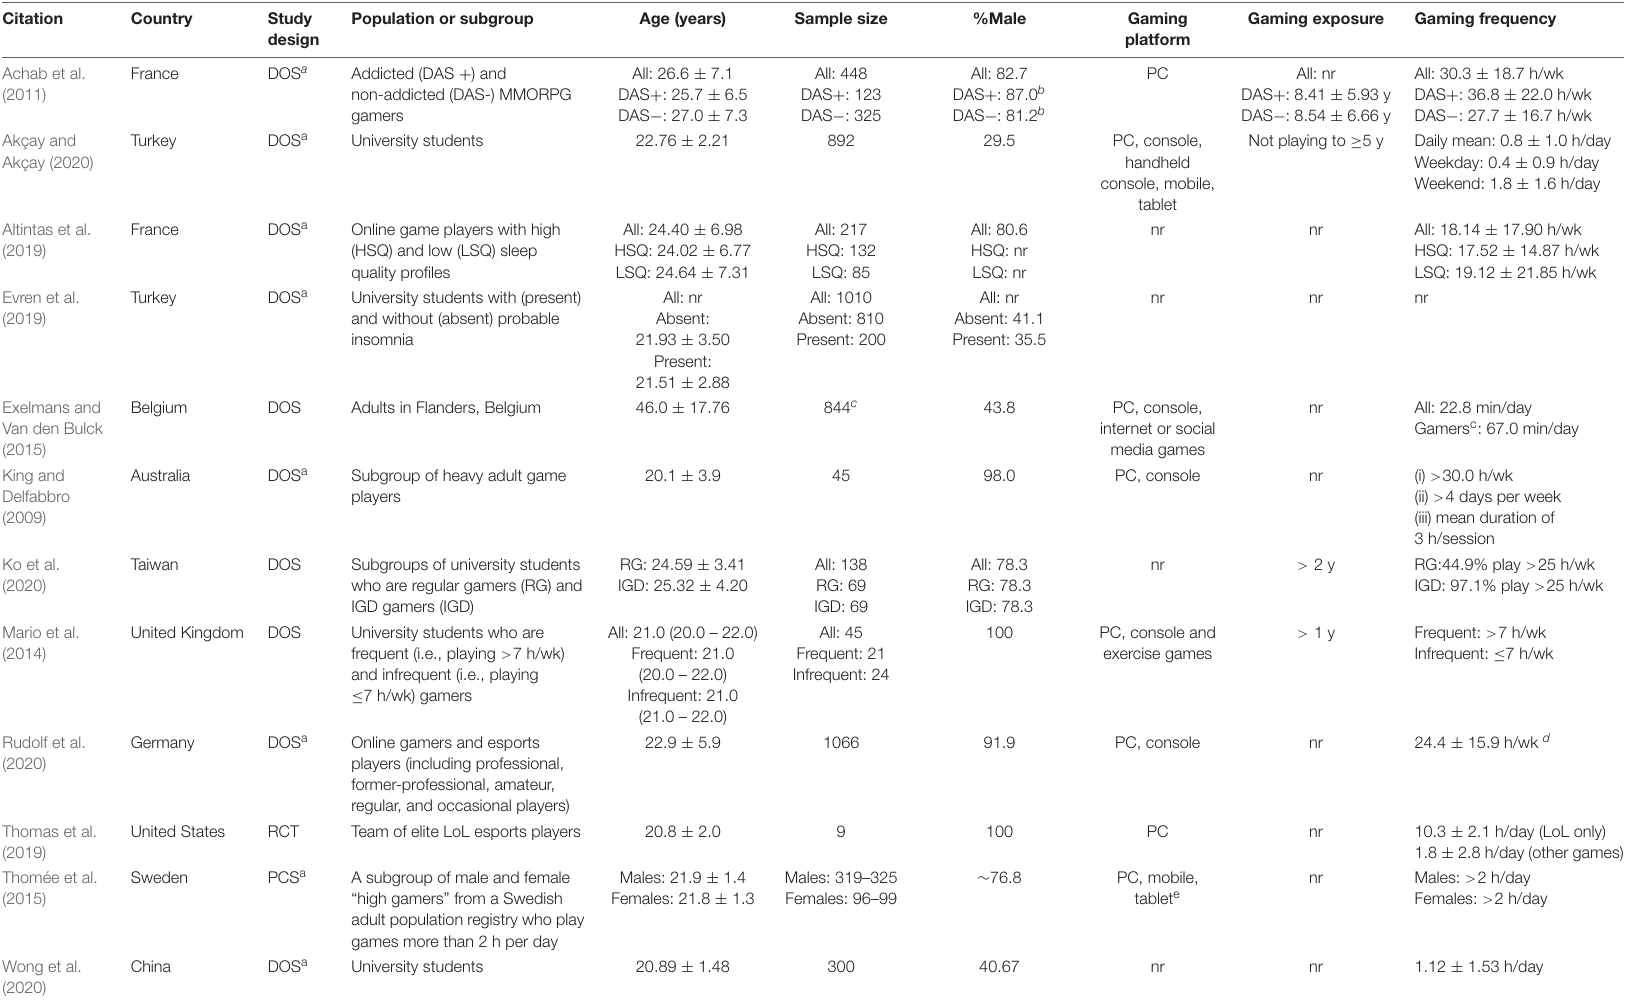
TABLE 2 | Demographic characteristics of the included